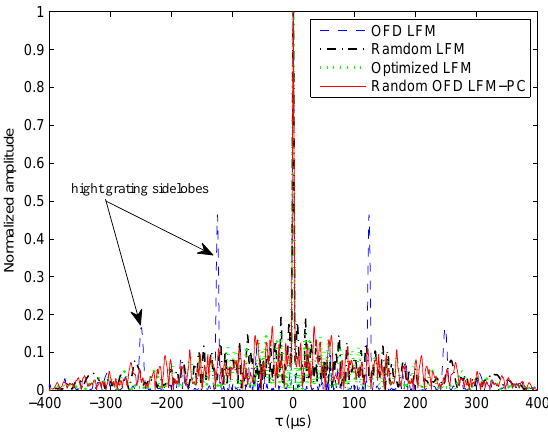
Figure 7. The autocorrelation functions of different angular